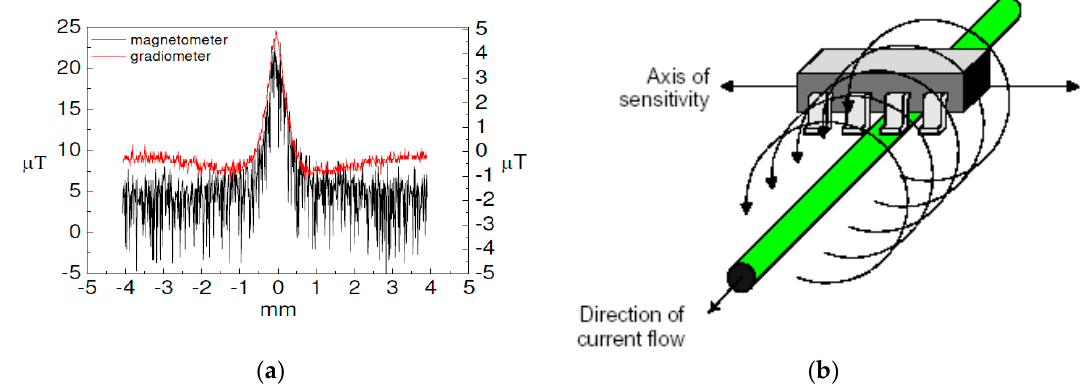
Figure 7. ( a ) Comparison between the magnetic field, detected by the GMR magnetometer (black line, scale on the left y-axis) and the 2nd order GMR gradiometer (red line, scale on the right y-axis), produced by an electric wire positioned at 0 mm on the x-axis, and the left and the right y-axis is related to the output signal measured by the magnetometer and gradiometer, respectively; ( b ) the sketch of the wire (with diameter of 0.2 mm) and its magnetic field (circular arrows). The direction of the magnetic field is along the GMR axis of sensitivity.